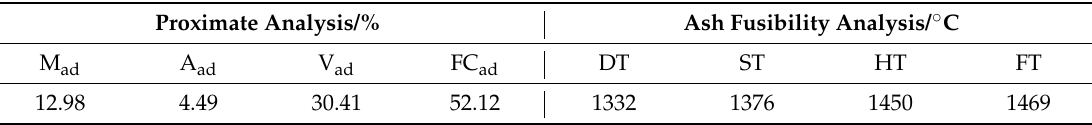
Table 4. Proximate and fusibility analysis results of soft coal.